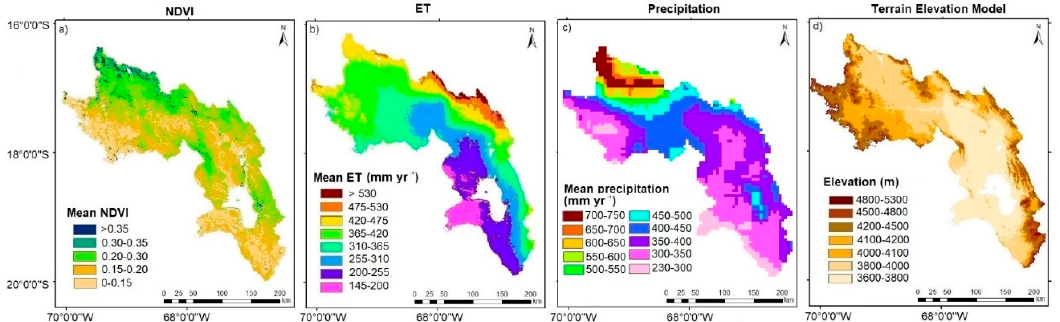
Figure 3. Spatial distribution of mean NDVI, ET and precipitation for the period 2002–2014 and terrain elevation of the DP system. ( a ) Mean NDVI; ( b ) Mean ET; ( c ) Mean annual precipitation; ( d ) Terrain elevation.